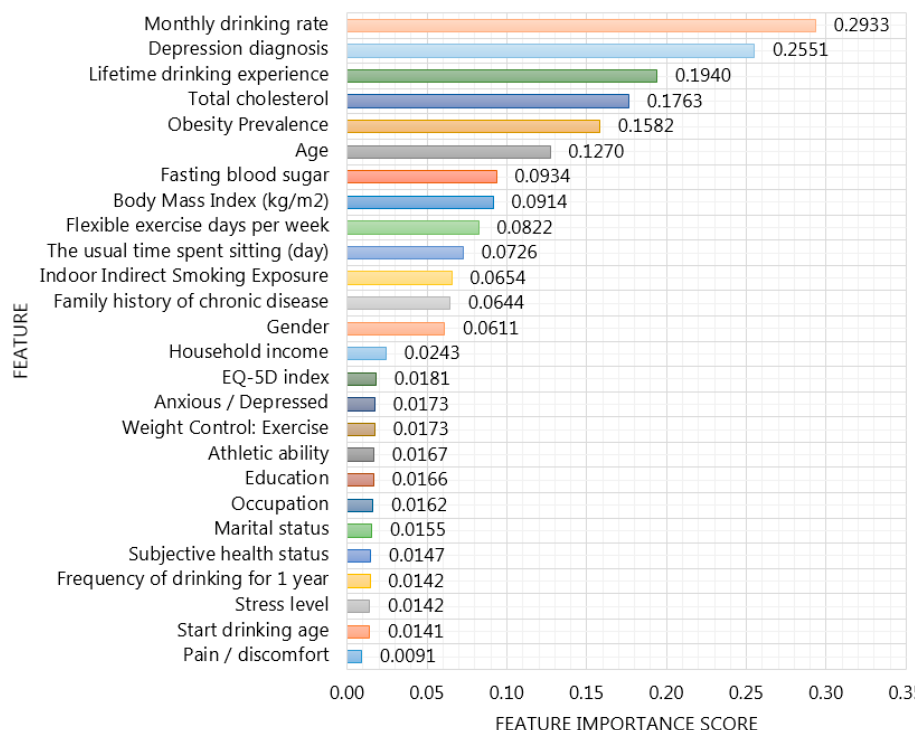
Figure 8. Feature Importance of XGBoost based framework incorporated with hybrid feature selection in the KNHANES dataset.